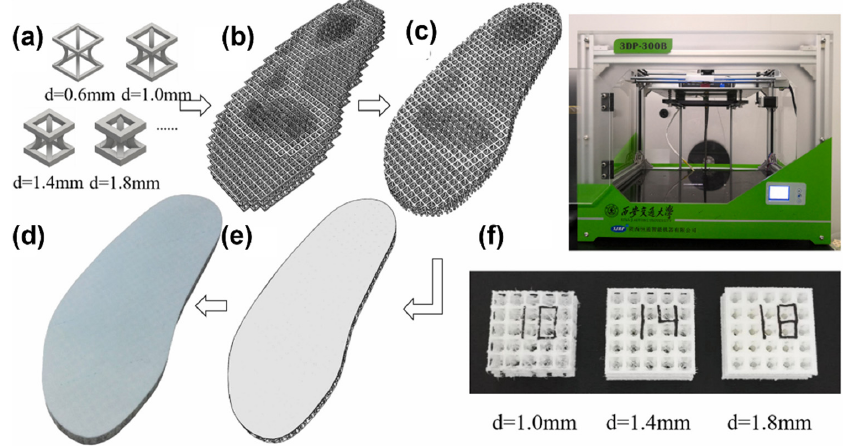
Figure 9. The process of designing and manufacturing gradient structure insole. ( a ) Different porous units to assembled ( b ) Porous substrate ( c ) Boolean intersection of the porous substrate and the original insole ( d ) The complete customized porous insole model ( e ) Manufactured porous customized flat insole and full contact insole ( f ) The printing machine and the 3D-printed testing samples [95].